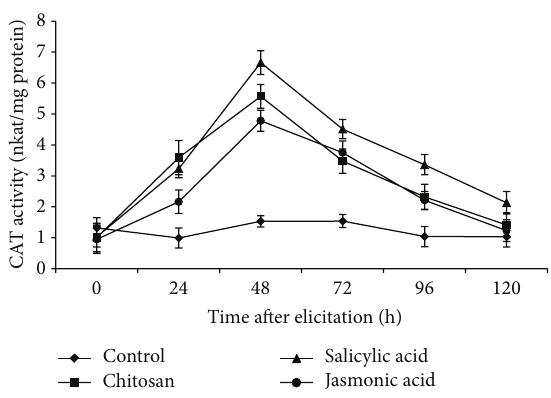
Figure 7: Catalase (CAT) activity (expressed as nkat/mg protein) in roots of tomato plants on a time course after elicitation of the plants with different elicitors. Values are mean ± SD of triplicate analysis.